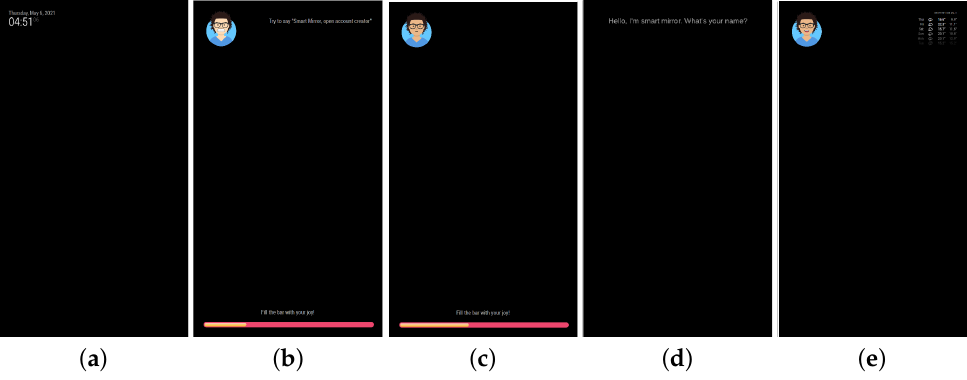
Figure 8. Pages that user can view. ( a ) Standby. ( b ) User not identified. ( c ) User identified. ( d ) Regis- tration. ( e ) User’s personal